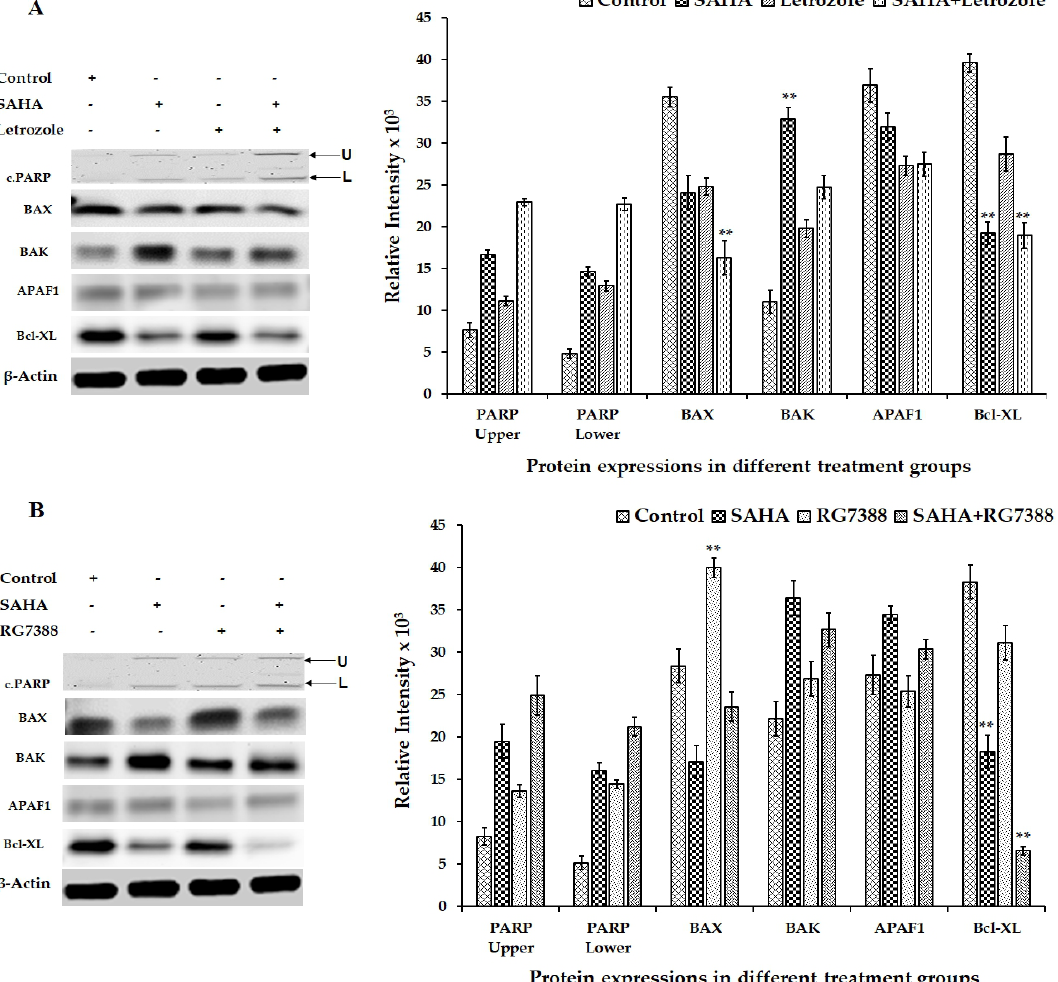
Figure 7. Representative western blot images showing the changes in the levels of apoptosis-related proteins in MCF-7 cells after SAHA, letrozole, RG7388 and combination treatments. ( A ) Modulation in the levels of apoptosis-related gene proteins such as cleaved PARP, BAX, BAK, APAF1, and Bcl-XL in MCF-7 cells treated with SAHA (7.5 µ M), letrozole (100 nM) and SAHA + letrozole for 24 h. ( B ) Modulation of apoptosis-related protein expressions in MCF-7 cells after SAHA (7.5 µ M), RG7388 (2.0 µ M) and SAHA + RG7388 treatment for 24 h. The right panel represents the band intensity of apoptosis proteins normalized to that of β -actin by ImageJ software. Data are presented as means ± SD from a minimum of three independent experiments. The level of significance is indicated as ** p < 0.01 compared to control.